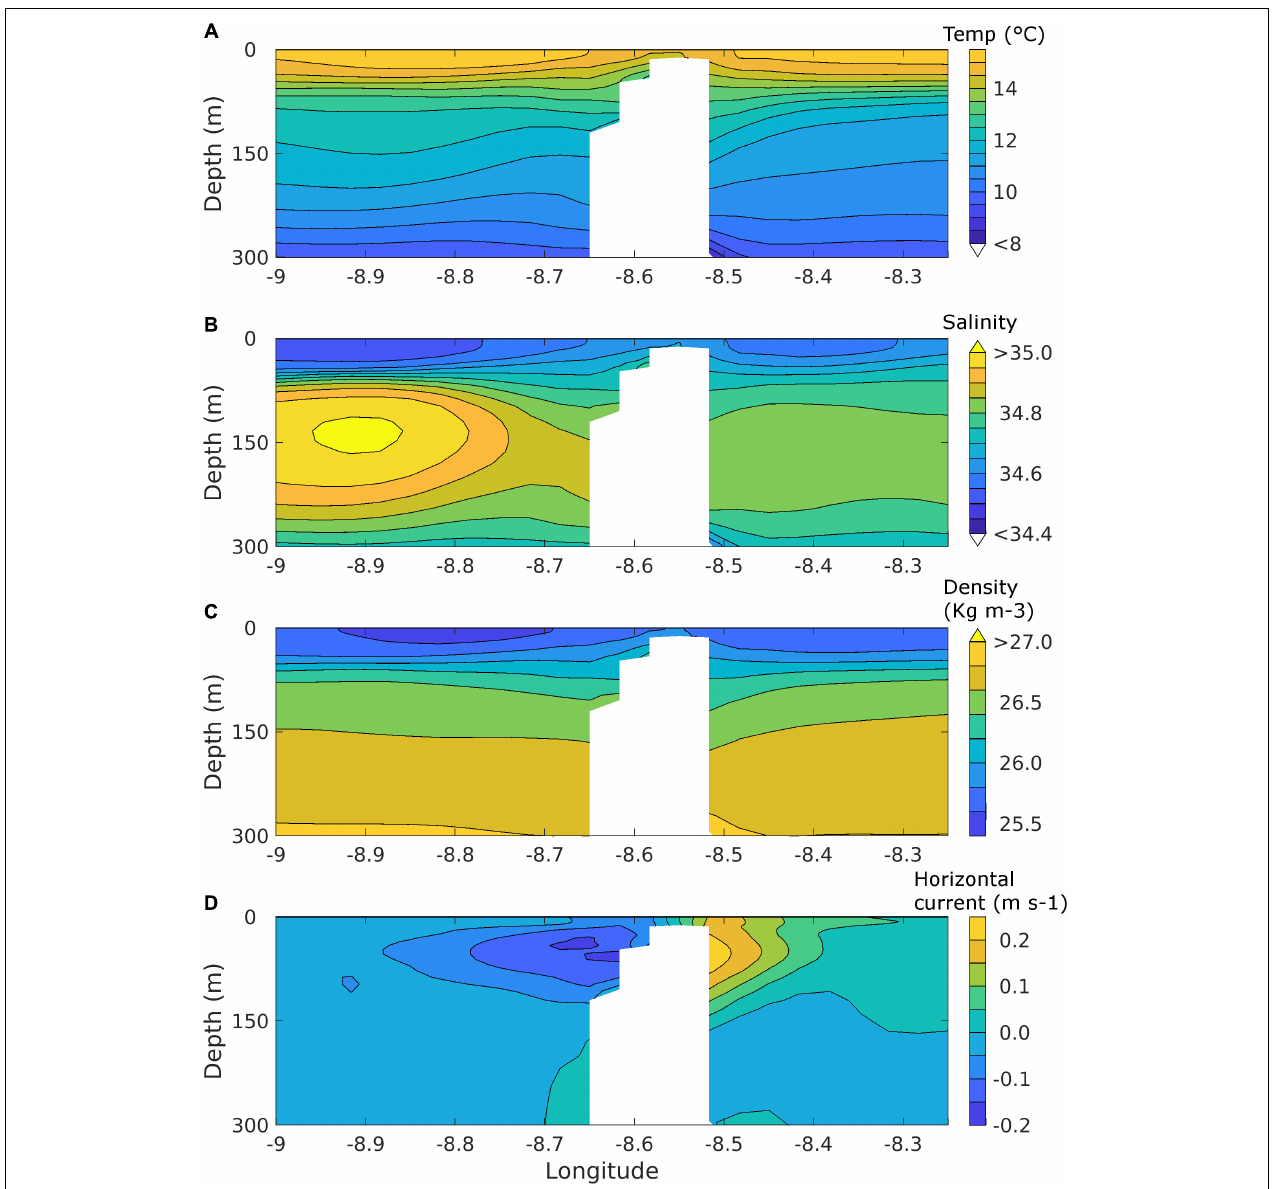
FIGURE 10 | Cross-section of 5-day mean (31/1/2006–4/2/2006) ocean properties along 40 ◦ 8"S from the regional oceanographic model: (A) potential temperature ( ◦ C), (B) salinity, (C) potential density ( σ , kg m − 3 ), (D) horizontal current (m s − 1 ). Positive (negative) horizontal currents are northward (southward). Model grid cells below the seabed are shaded